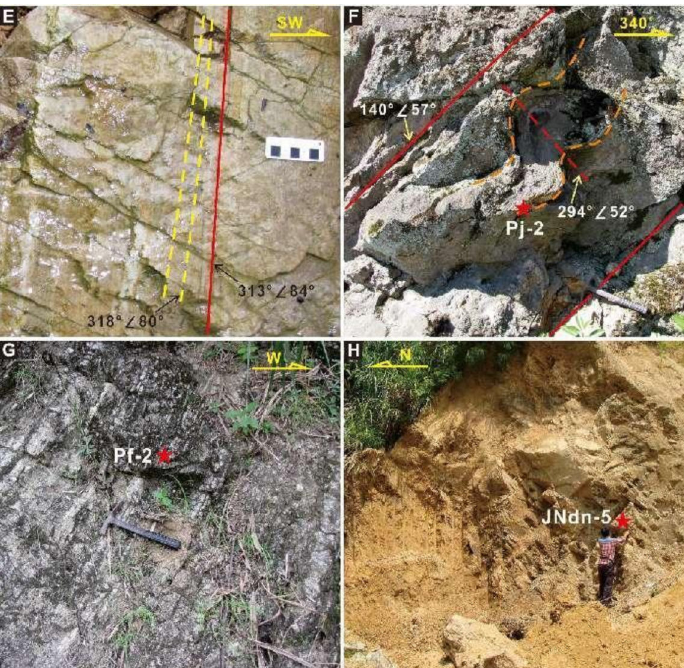
Figure 2. Representative field photos and photomicrographs of studied and sampled (northeastern Cathaysia block) meta-sediments, with indication of observed and measured sedimentary structures. ( A , G , H ) field outcrops of samples Zw-1, Pf-2, and JNdn-5, respectively. ( B , D ) photomicrographs of samples Zw-1 and Zd-3, respectively. ( C , E ) unidirectional cross-beddings CBC03 and CBC01, with indication of occurrence of the foreset laminae. ( F ) syndepositional fold SFoC01, occurrence of fold axial plane is marked. The red lines represent bedding planes. The red dashed lines represent the axial plane of the fold. The yellow and brown dashed lines represent foreset laminae and folds, respectively. The red stars and white numbers represent sampling sites and sample codes, respectively. Qz: quartz. Refer to the text for detailed